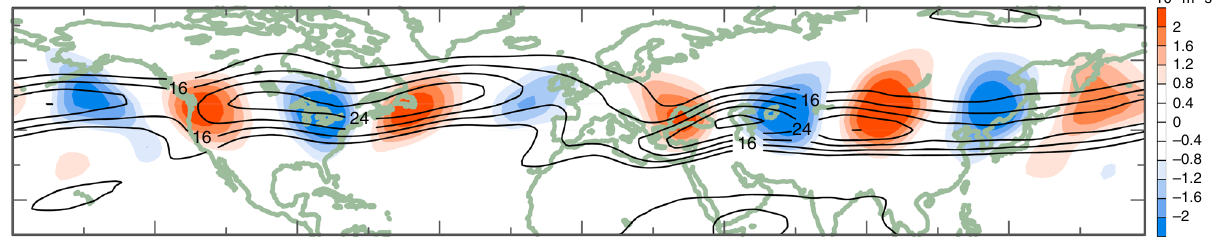
Fig. 5 Enhanced circumglobal wave train embedded in the summer jet. Linear trends from 1979 to 2010 in the July 250 hPa stream function in the short- wave regime (blue-red shading) computed with the long wavenumbers (1 – 4) removed. The change in the short waves is embedded in the climatological July-mean 250-hPa wind speed depicting the jet stream (black contour lines). Adapted from (Wang et al. 95